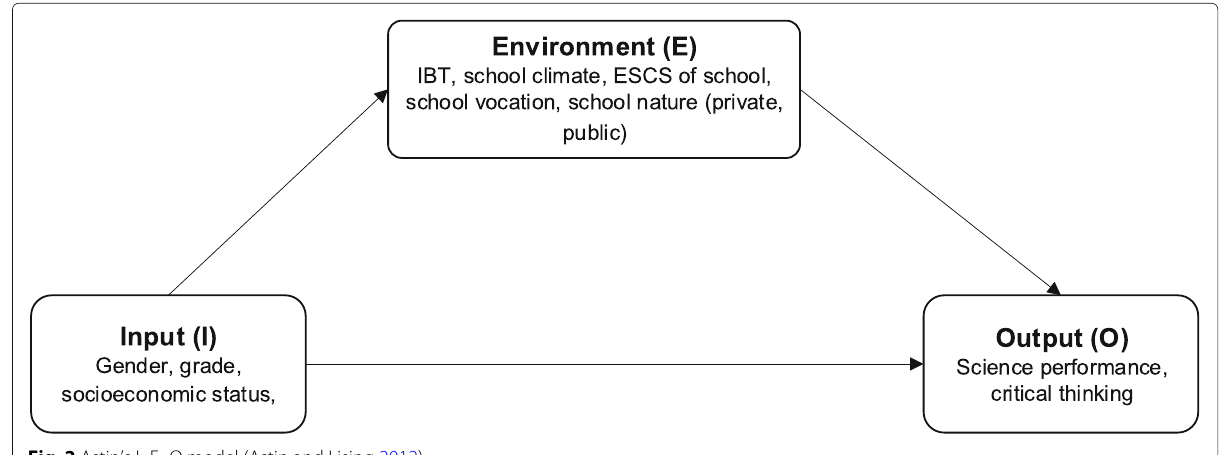
Fig. 2 Astin’s I–E–O model (Astin and Lising